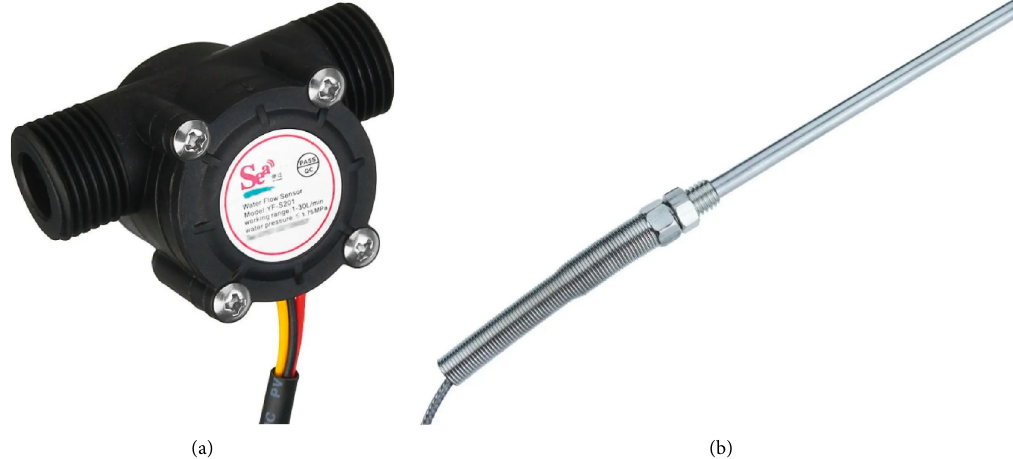
Figure 7: (a) Temperature sensor. (b) Flow